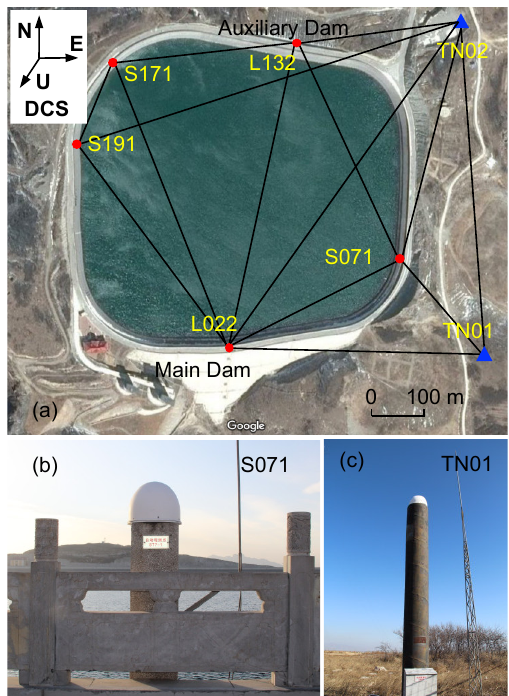
Figure 2. ( a ) Station layout at the head reservoir of the Xilongchi pumped-storage power station: ( b ) monitoring station S071 and ( c ) reference station TN01. Table 1. Baseline information for the GPS